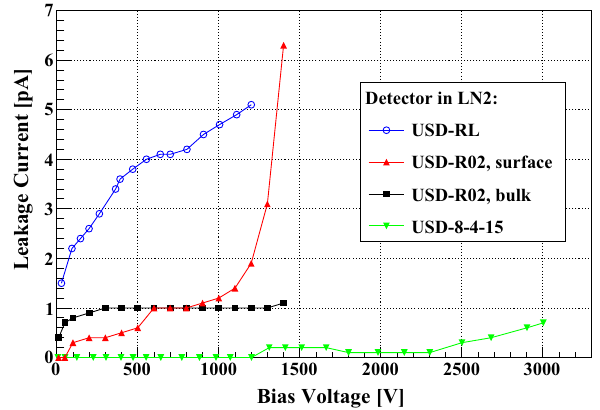
Fig. 16 Highest leakage currents of the three detectors measured in LN